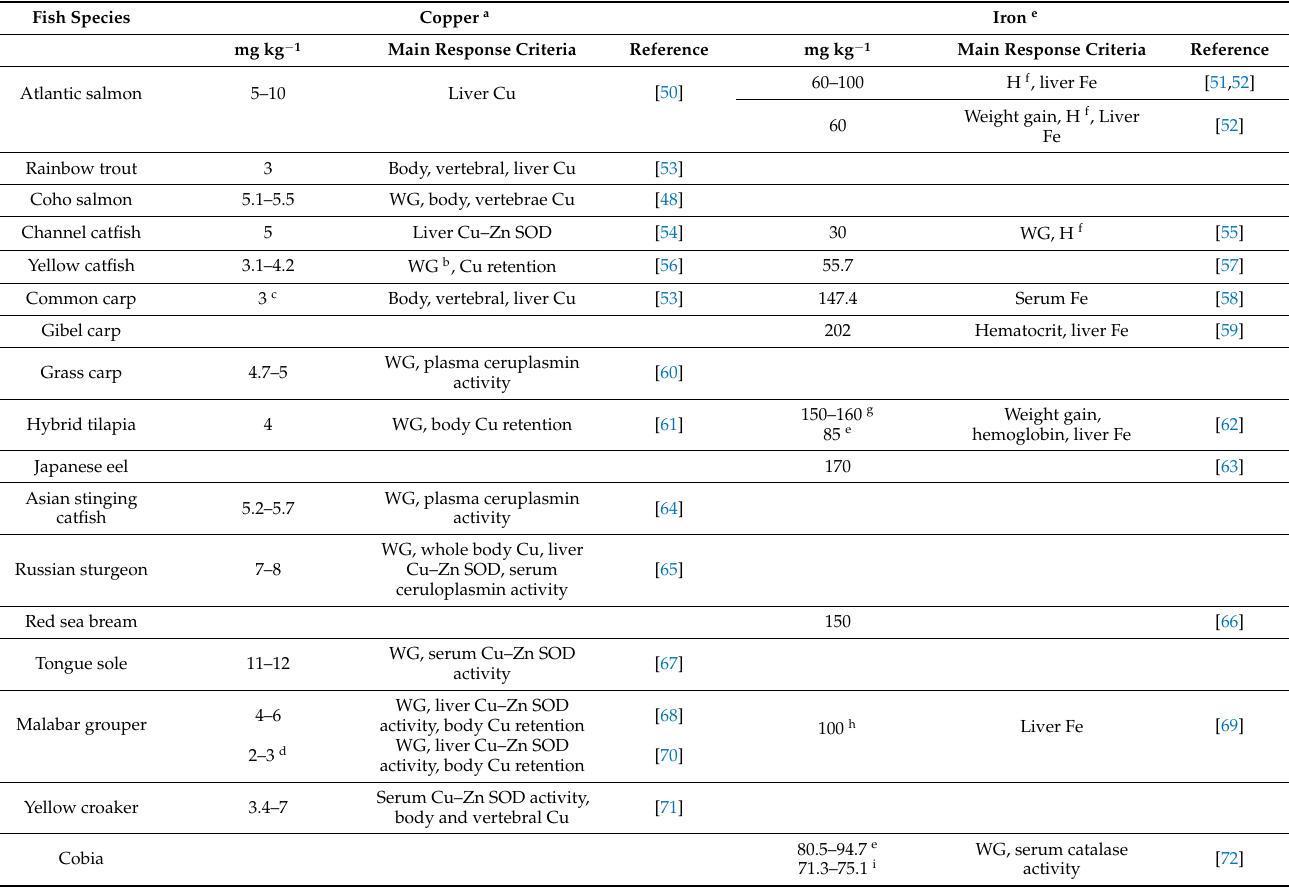
Table 1. Iron and copper requirement of